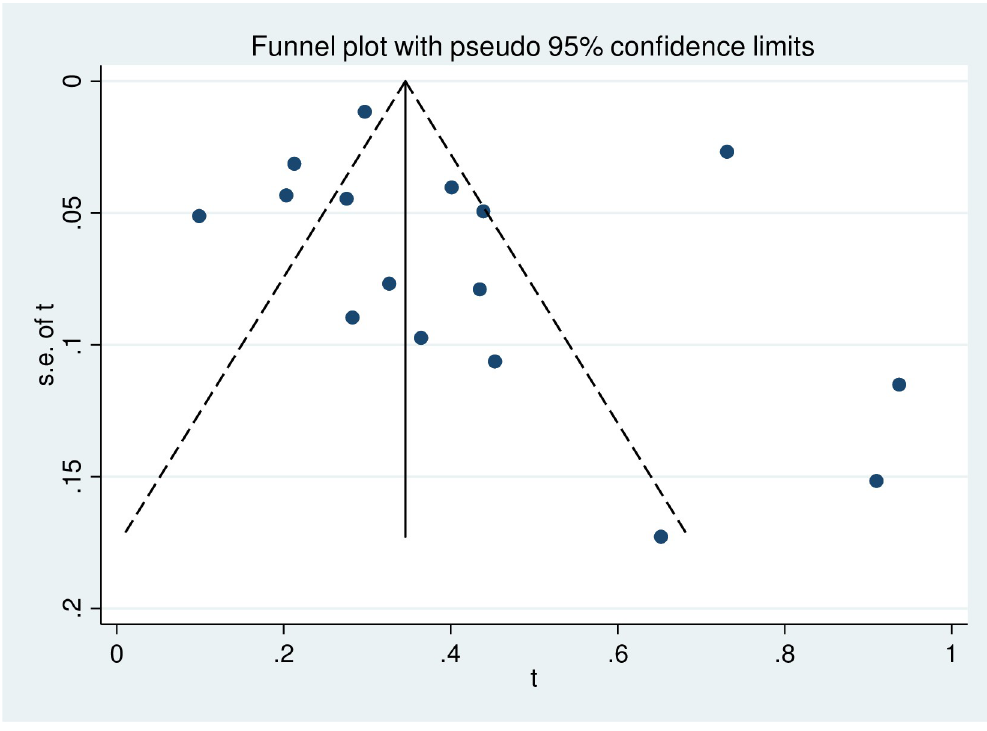
Fig 2. Meta funnel plot for publication bias. Prevalence estimate of MDR-TB among newly diagnosed TB cases in East Africa, 2007 to 2019. Abbreviation: t: arcsine transformed prevalence estimate of MDR-TB and se of t, standard error of t.